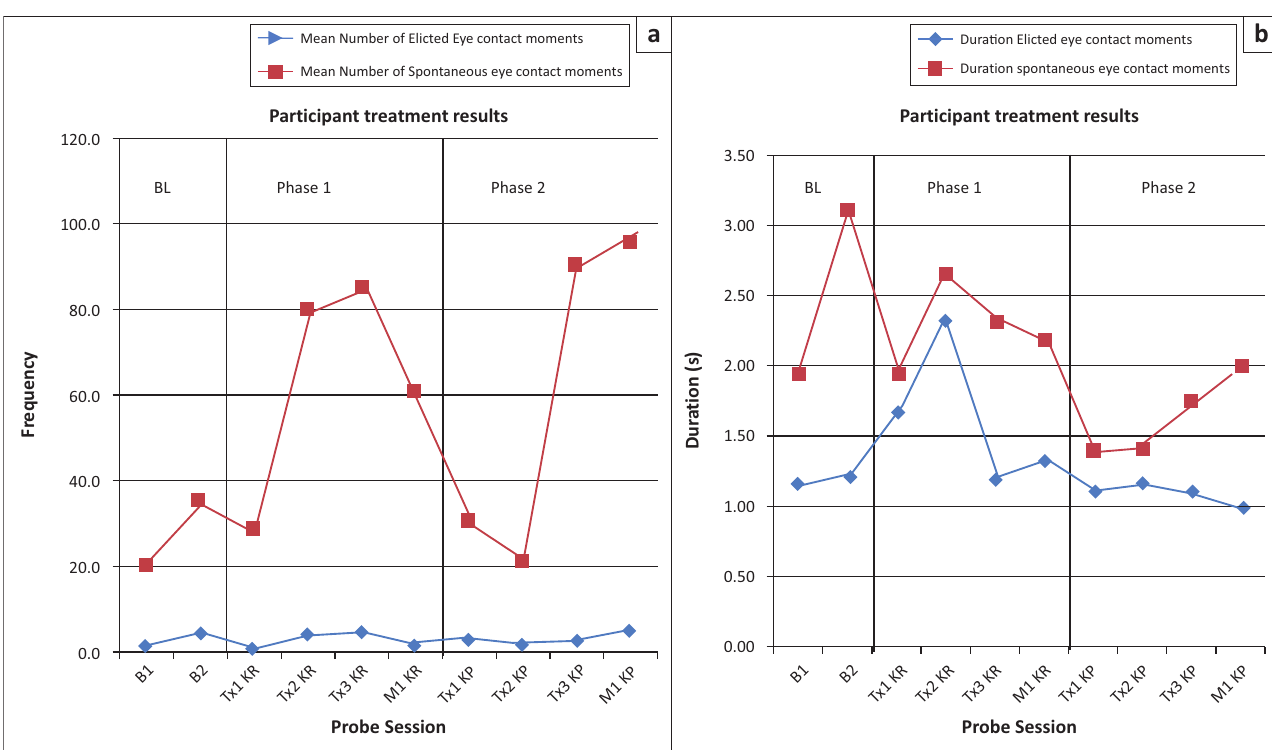
FIGURE 1: Mean number (a) and duration (b) of elicited and spontaneous eye contact